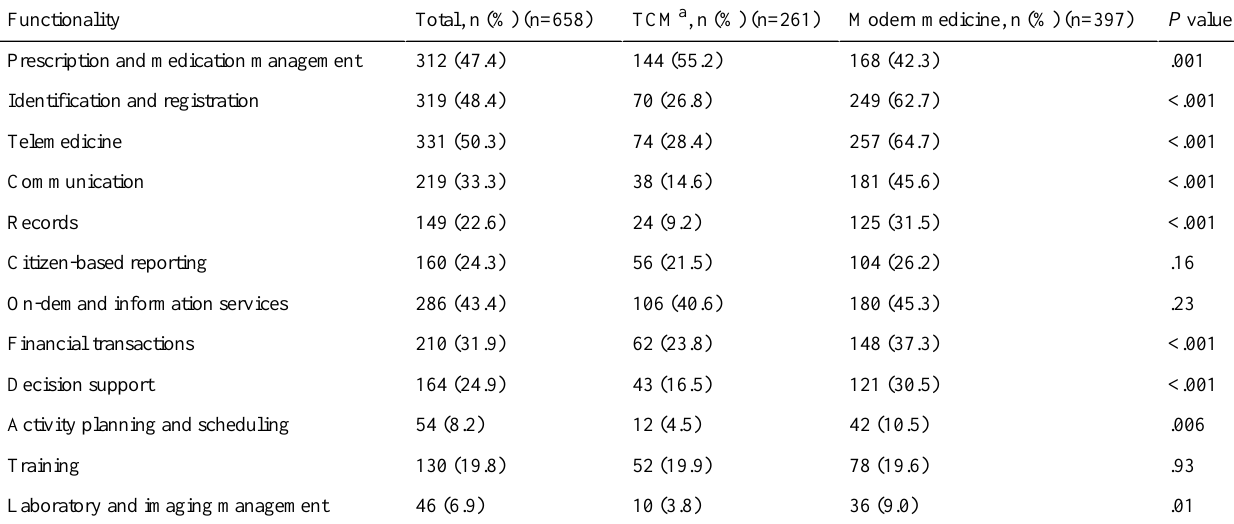
Table 2. Frequency of app functionalities.